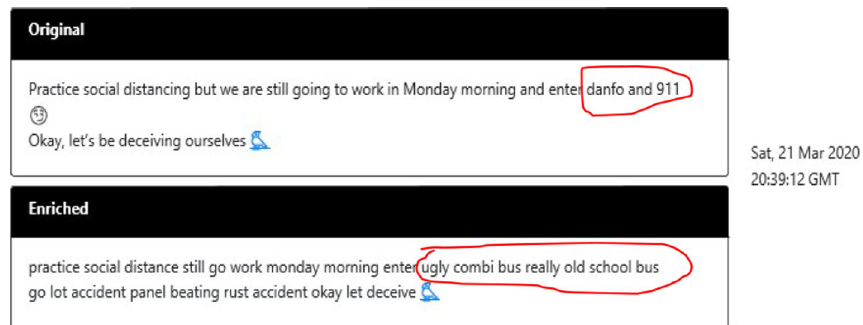
Fig. 5 A snapshot of the Original and the Enriched